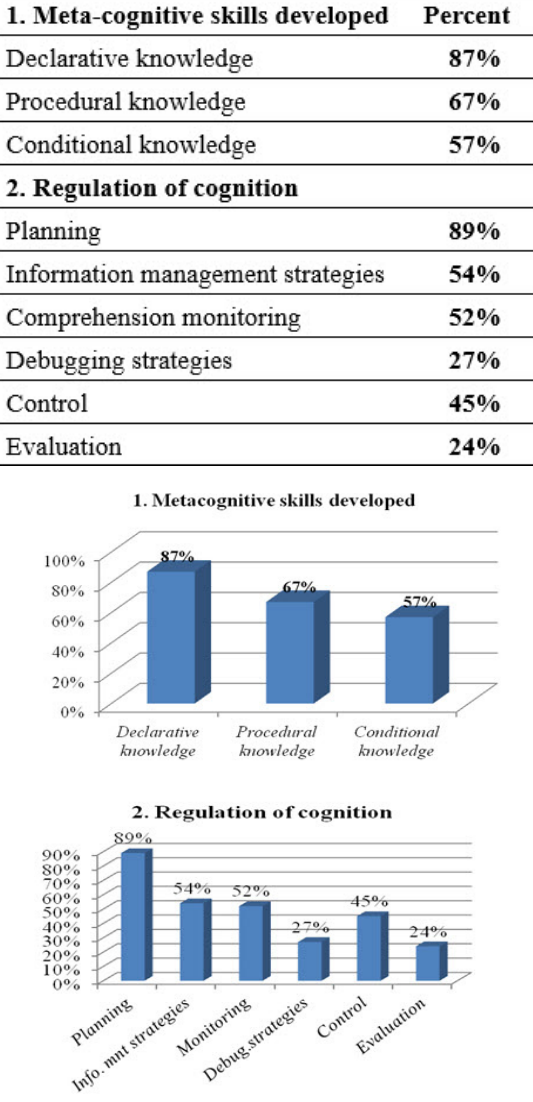
Table 1. Meta-cognition awareness de- velopment (at the beginning of the experi- mental learning)